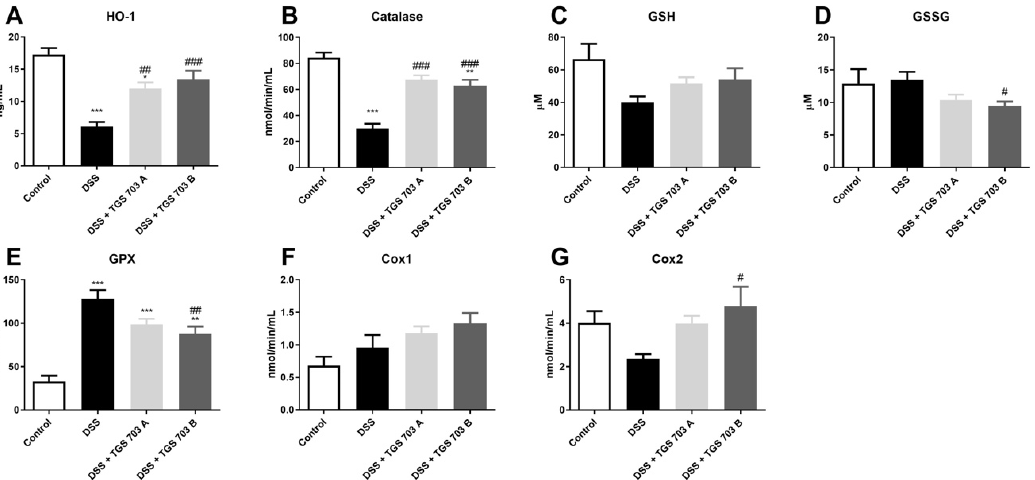
Figure 10. The influence of DSS colitis and TGS 703 treatment on the antioxidant profile in the mouse colon: heme oxygenase-1 ( A ), catalase ( B ), glutathione ( C ), glutathione disulfide ( D ), glutathione peroxidase ( E ), cyclooxygenase-1 ( F ), and cyclooxygenase-2 ( G ) for control, DSS-only treated mice, and mice with DSS-induced colitis treated with TGS 703 in two doses: 1.68 µ g/kg (TGS 701 0.1A) and 16.8 µ g/kg (TGS 703 1A). * p < 0.05, ** p < 0.01, *** p < 0.001 as compared with the control